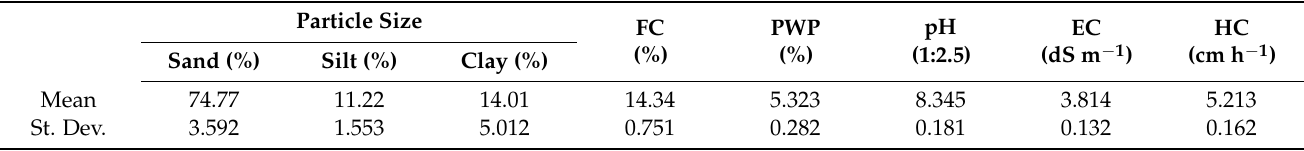
Table 1. Average ± standard deviation of some physicochemical and hydraulic characteristics of the experimental soil. Particle Size FC